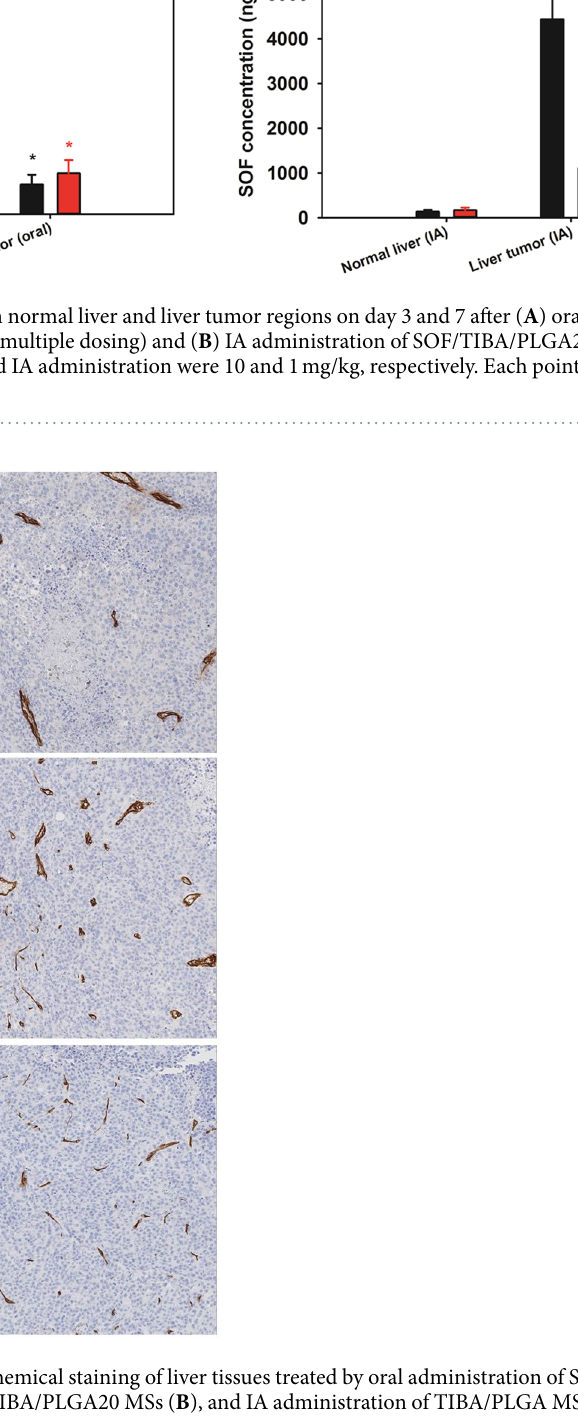
(IA) and TIBA/PLGA MS (IA) groups (Fig. 8). White blood cell (WBC) counts were substantially elevated at day 1 in the two IA groups, while relatively unchanged in the SOF solution (oral) group (Fig. 8). Hemoglobin and creatinine levels were consistent during the follow-up period in all groups.